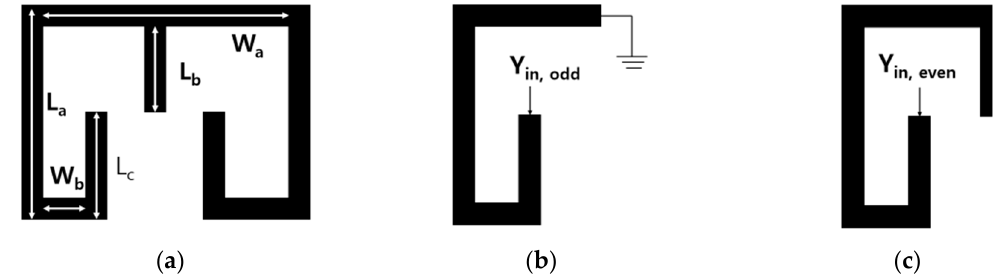
Figure 2. Layout of the proposed ( a ) dual-mode folded open-loop and stub-loaded resonators (SLRs). ( b ) Odd-mode equivalent circuit. ( c ) Even-mode equivalent circuit.